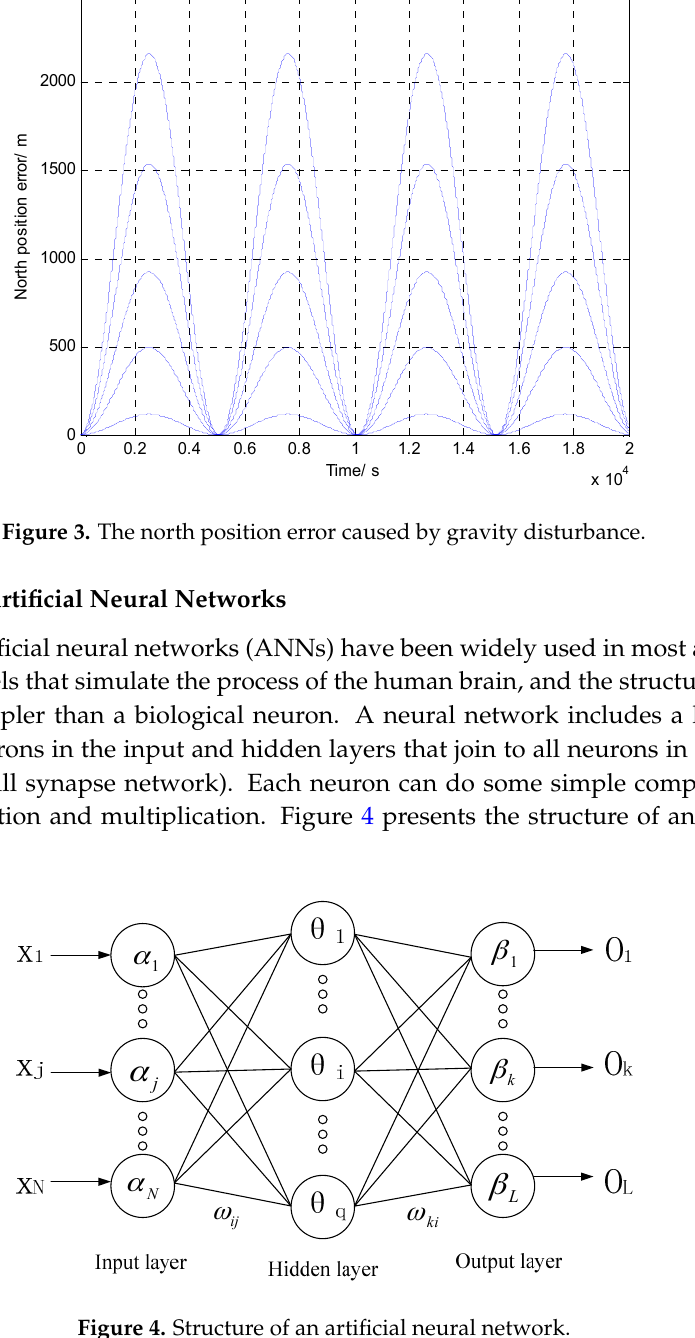
Figure 4. Structure of an artificial neural network.